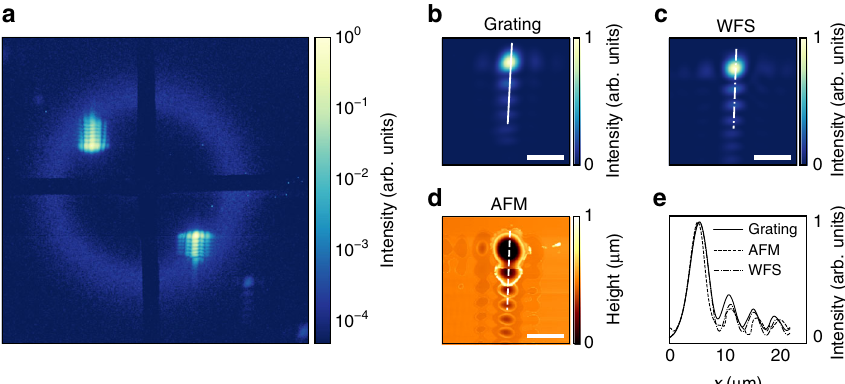
Fig. 4 Single-shot spatial fl uence distribution and primary sample signal. a Logarithmic false-color image of a single-shot diffraction pattern with sample signal (ring-shaped feature) and spatial fl uence distributions. b Crop of the spatial fl uence map from a on a linear intensity scale. c Spatial fl uence distribution in the sample plane on a linear scale, extrapolated from a Hartmann wave-front sensor (WFS) measurement of a different FEL single-shot. d Atomic force micrograph (AFM) of a single-shot damage crater in the sample substrate. All scale bars correspond to 10 μ m. e Line pro fi les along the indicated lines in b – d . To extract an intensity pro fi le from d , we assume that the absorption in the substrate material follows a Beer – Lambert law. Neglecting thermal melting and redeposition, the damage crater topography then represents the surface of constant intensity at which the incident fl uence is attenuated below the ablation threshold 13